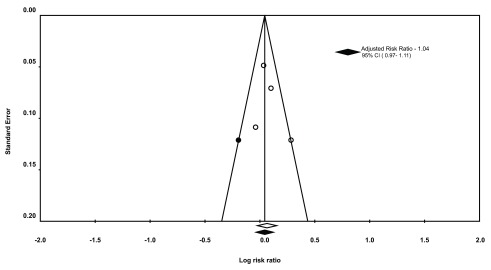
Filled funnel plot using the trim and fill method for succesful pleurodesis rates post talc pleurodesis: imputed studies - ●, observed studies - ○,
CI – confidence interval.